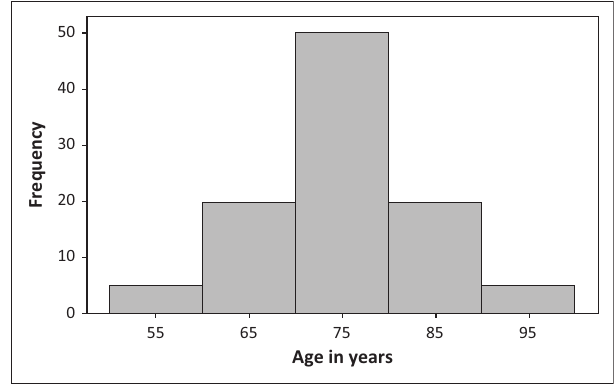
FIGURE 5: A histogram showing the distribution of ages of people in a region. data. I will use an example to illustrate how histograms represent continuous